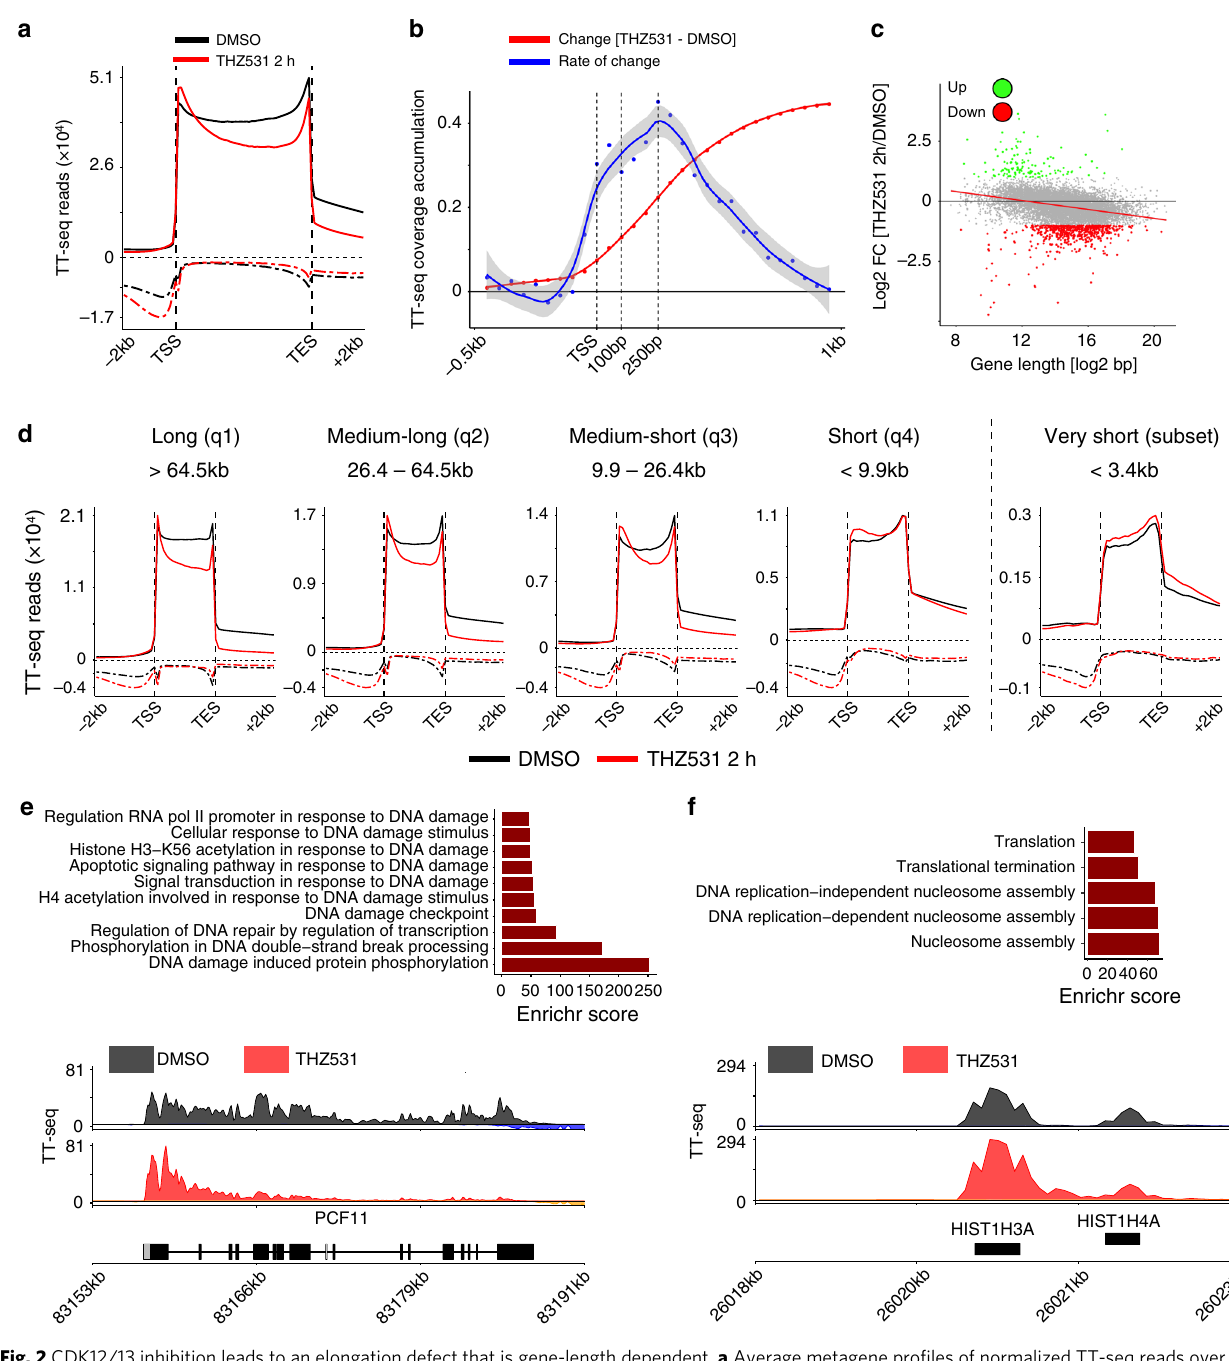
Fig. 2 CDK12/13 inhibition leads to an elongation defect that is gene-length dependent. a Average metagene pro fi les of normalized TT-seq reads over gene bodies and extending − 2 to + 2 kb of all detected genes in cells treated with THZ531 400 nM for 2 h. Sense and antisense reads are depicted by solid and dashed lines respectively. b Average metagene pro fi le depicting the change (red) and rate of change (blue) in TT-seq read densities in regions fl anking the TSS ( − 0.5 to + 1 kb) in cells treated with THZ531. c Scatter plot showing log2 fold-changes in gene expression vs. gene length in log2 scale for each protein coding gene in cells treated as in panel a ( R 2 = 0.12, p = 2e − 277, F -test, Spearman correlation coef fi cient = − 0.42). Differentially expressed genes are indicated (FDR < 0.1 and log2 FC > 1). d Average metagene pro fi les for protein-coding genes (as in a ) strati fi ed according to quartiles of gene length distribution and for very short genes. Sense and antisense reads are depicted by solid and dashed lines respectively. e Gene ontology (GO) enrichment analysis of long genes (>64.5 kb) (top); TT-seq tracks of nascent RNA expression at the PCF11 locus in NB cells treated with DMSO or THZ531 as in panel a (bottom). f GO enrichment analysis of very short genes (<3.4 kb) (top); TT-seq tracks at the HIST1H3A/HIST1H4A loci